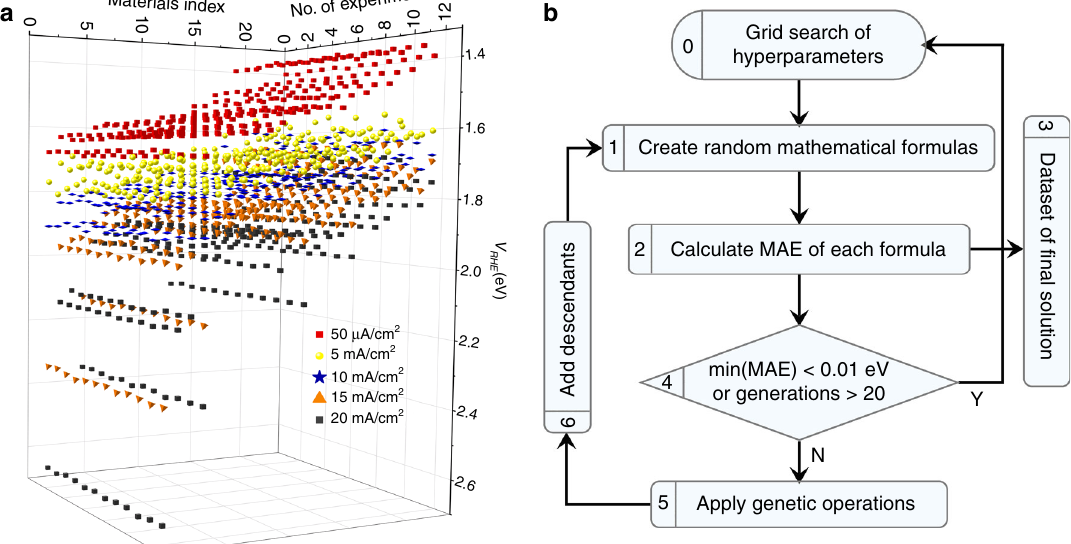
Fig. 2 Data collection and process. a The landscape of all V RHE data produced by experiments, including eighteen conventional and fi ve new perovskites (totally twenty-three perovskites listed as ‘ Materials index ’ with sequence shown in Table 1). Each perovskite has been made four samples and each sample has been measured three times (totally twelve measurements listed as ‘ No. of measurements ’ ). For each measurement, we adopted V RHE values at fi ve current densities of 50 µ A cm − 2 , 5 mA cm − 2 , 10 mA cm − 2 , 15 mA cm − 2 , and 20 mA cm − 2 . The exact values of those data points are provided in Supplementary Data 1 – 5. b The fl owchart of symbolic regression based on genetic programming (see more details of this fl owchart and SR in Supplementary